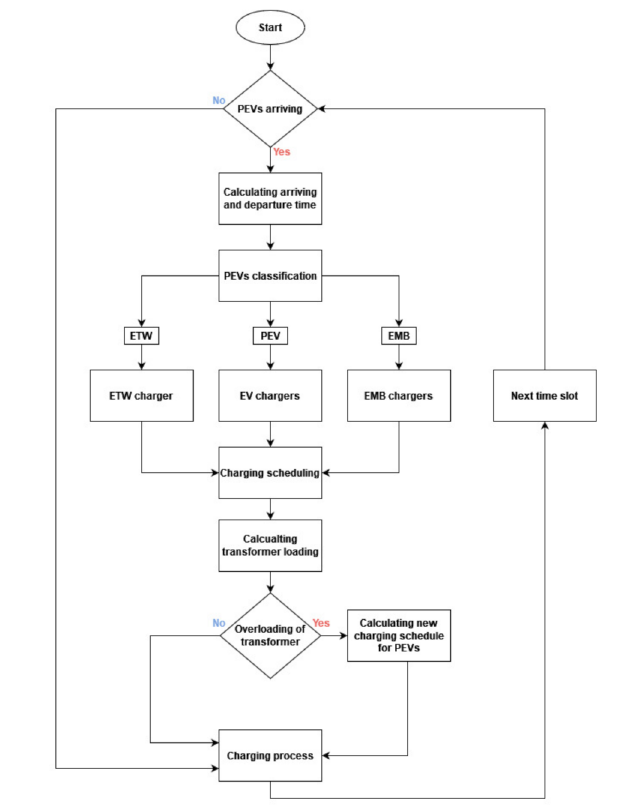
Figure 7. Flow chart for coordinated